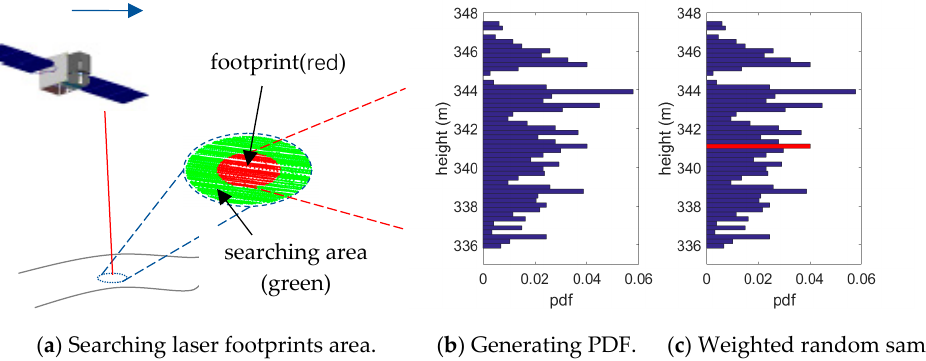
Figure 3. Simulation process of the spaceborne photon count laser altimeter data.